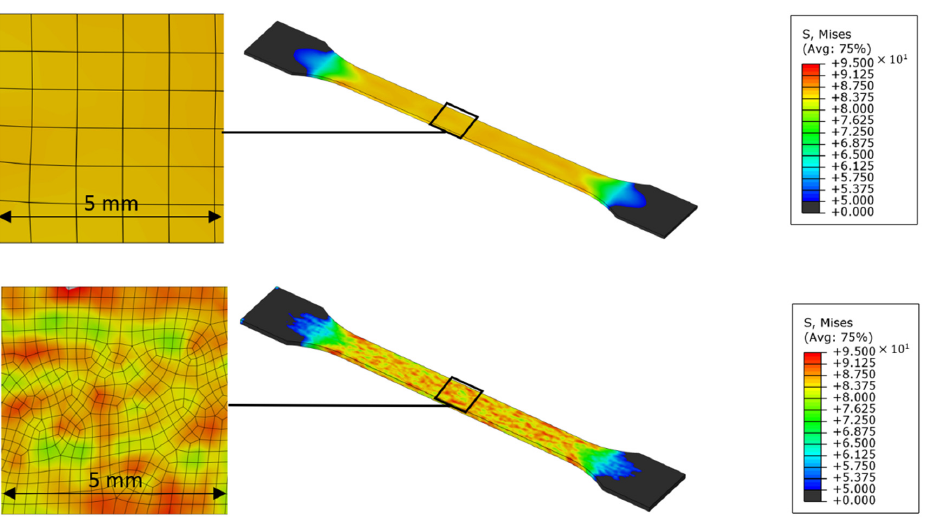
Figure 15. FEA with two different mesh sizes (top: 1.0 mm, bottom: 0.25 mm) of a test specimen with uniform fiber orientation under consideration of the statistical deviation of the effective Young’s modulus due to the effect of different fiber ensembles.